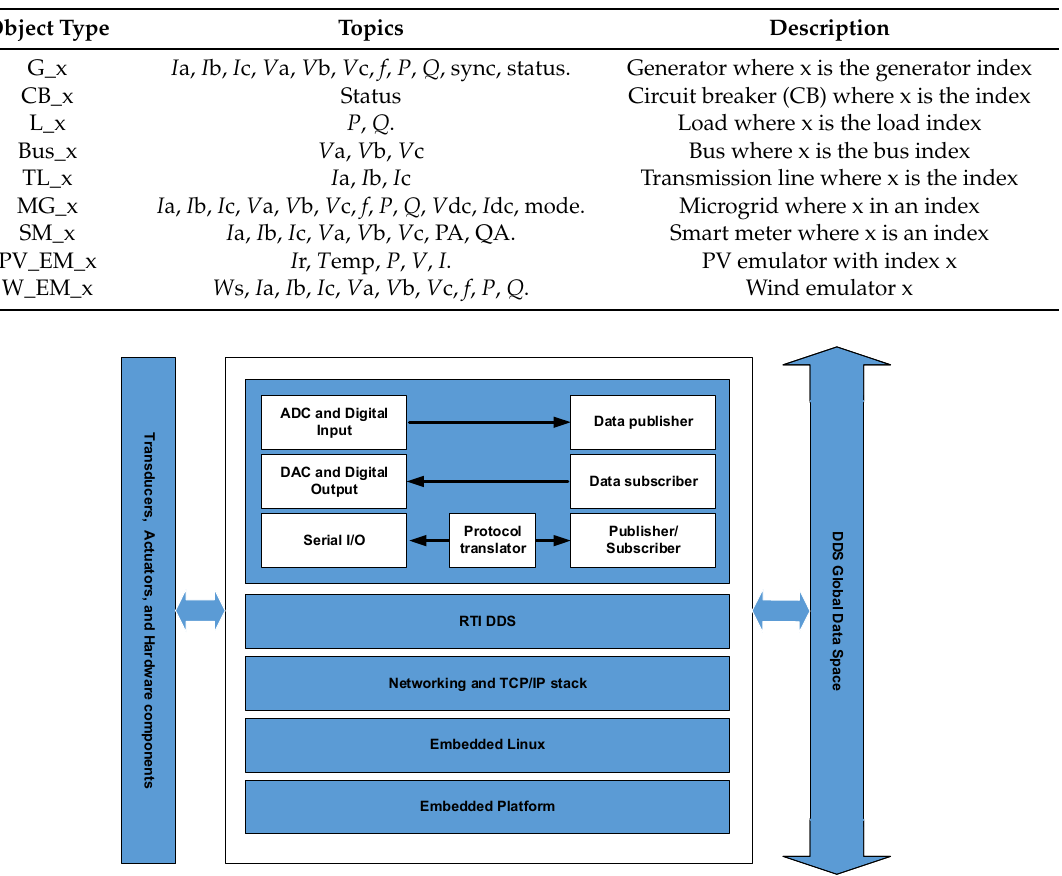
Figure 4. The developed data distribution service (DDS) data acquisition (DAQ) and controller block diagram.